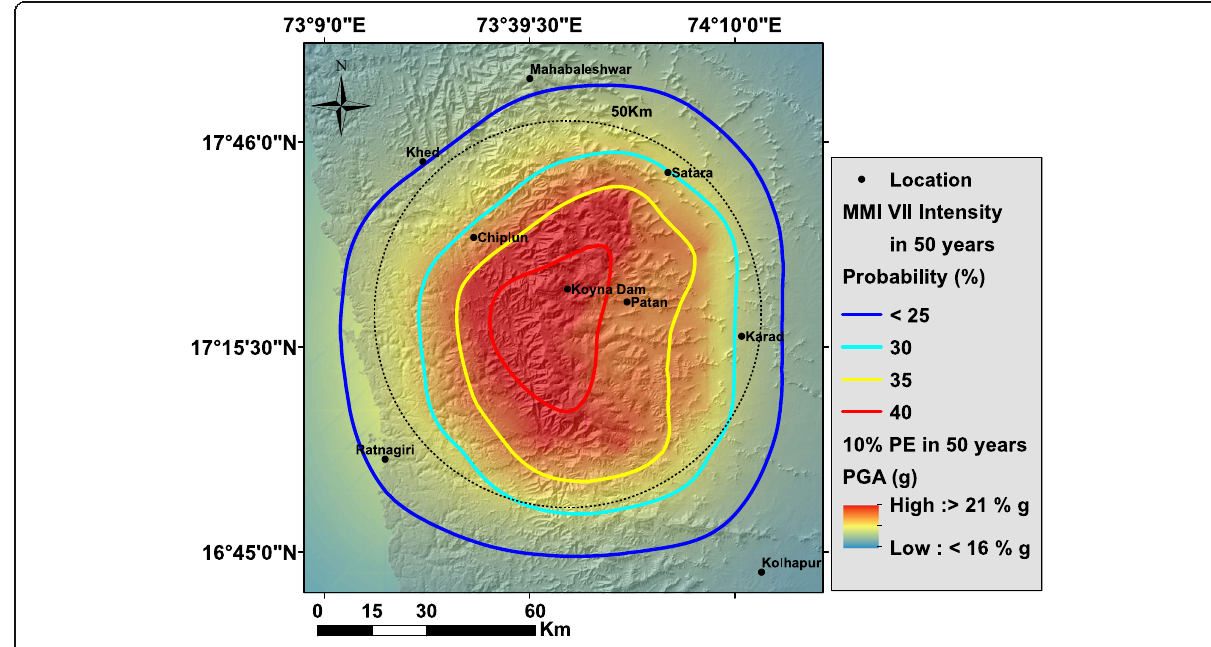
Fig. 8 Spatial distribution of estimated PGA (% g) as hazard levels and MMI – VII as damage potentials in 50